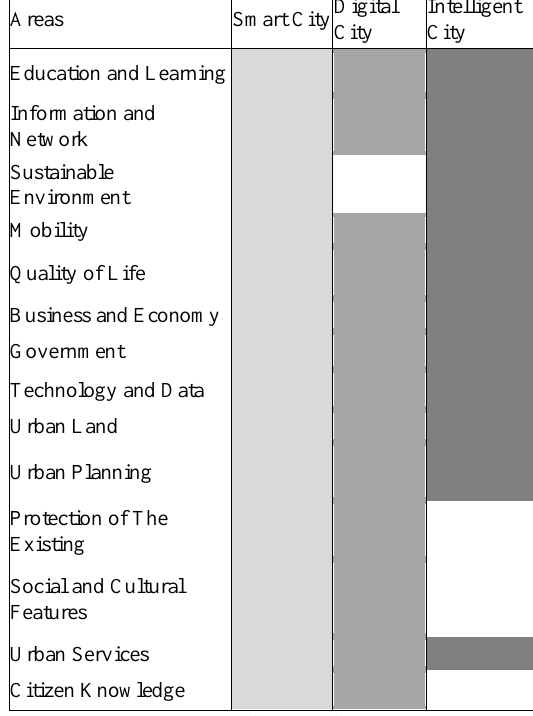
Table 5. Areas of interest for